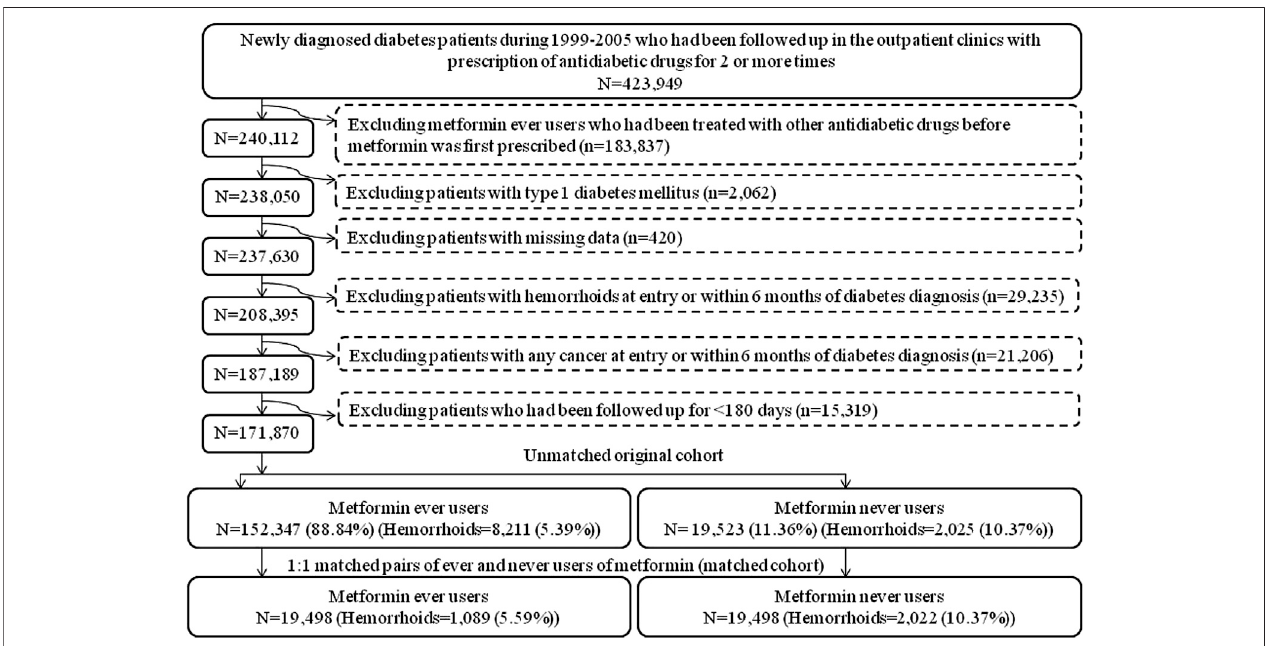
FIGURE1 | Flowchart showing the procedures in creatingan unmatched cohort and acohort of 1:1matched-pairs (based on propensity score) of metformin ever users and never users from the reimbursement database of the Taiwan ’ s National Health Insurance.